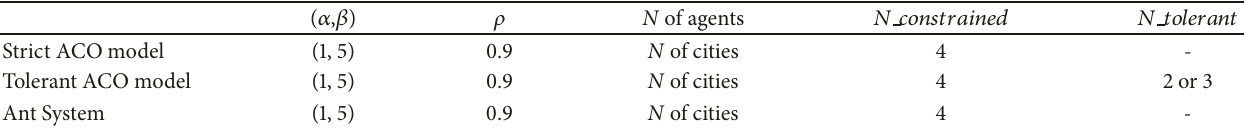
Table 1: Parameters for the calculation.